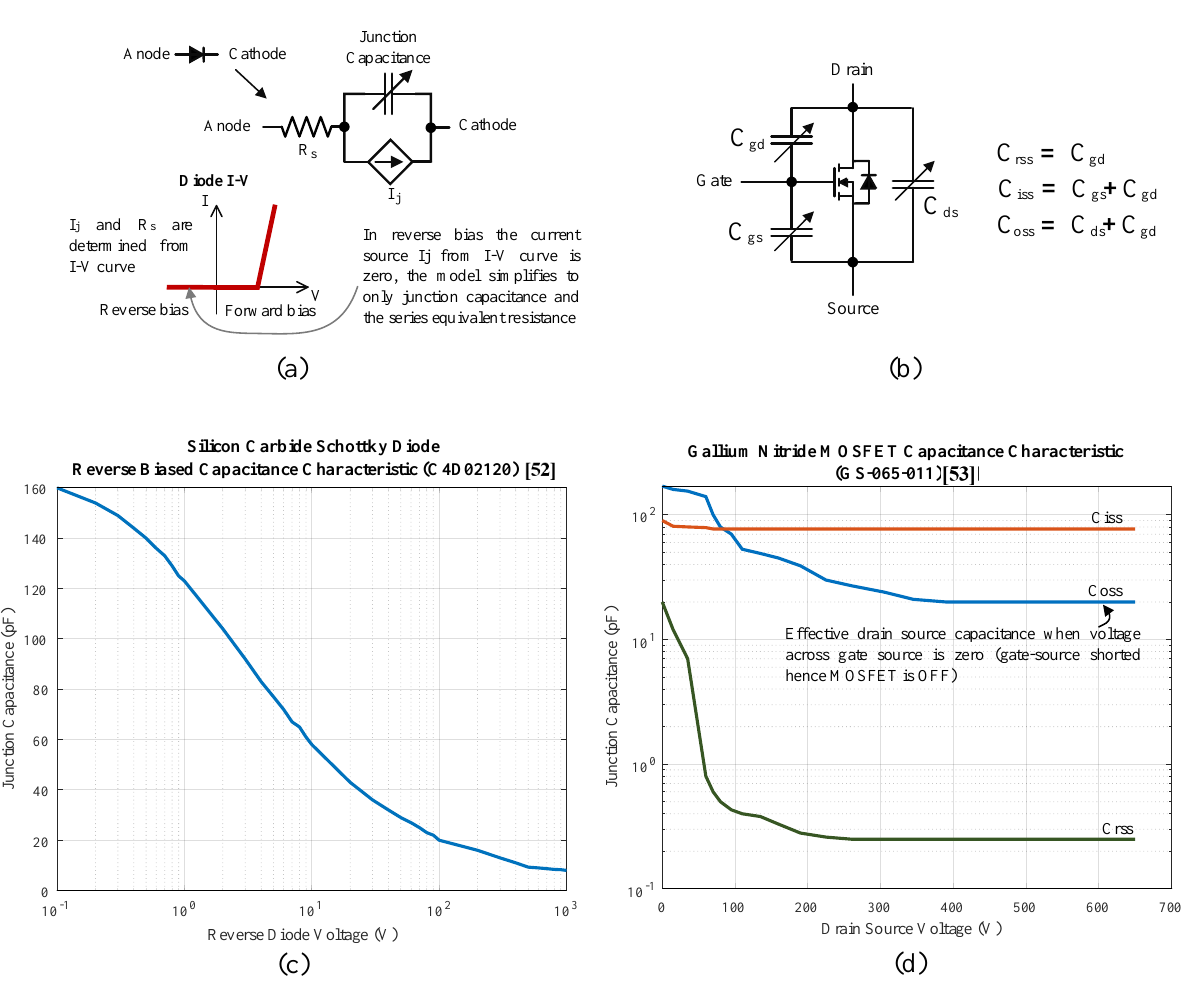
Figure 7. The junction capacitance of semiconductor device. ( a ) The SiC diode model [50]. ( b ) MOSFET parasitic capacitances [19,22,51]. ( c ) SiC Diode C4D02120 capacitance characteristic adapted from Cree C4D02120 datasheet [52]. ( d ) GaN GS-065-011-L capacitance characteristic adapted from GaN System GS-065-011-L datasheet [53].